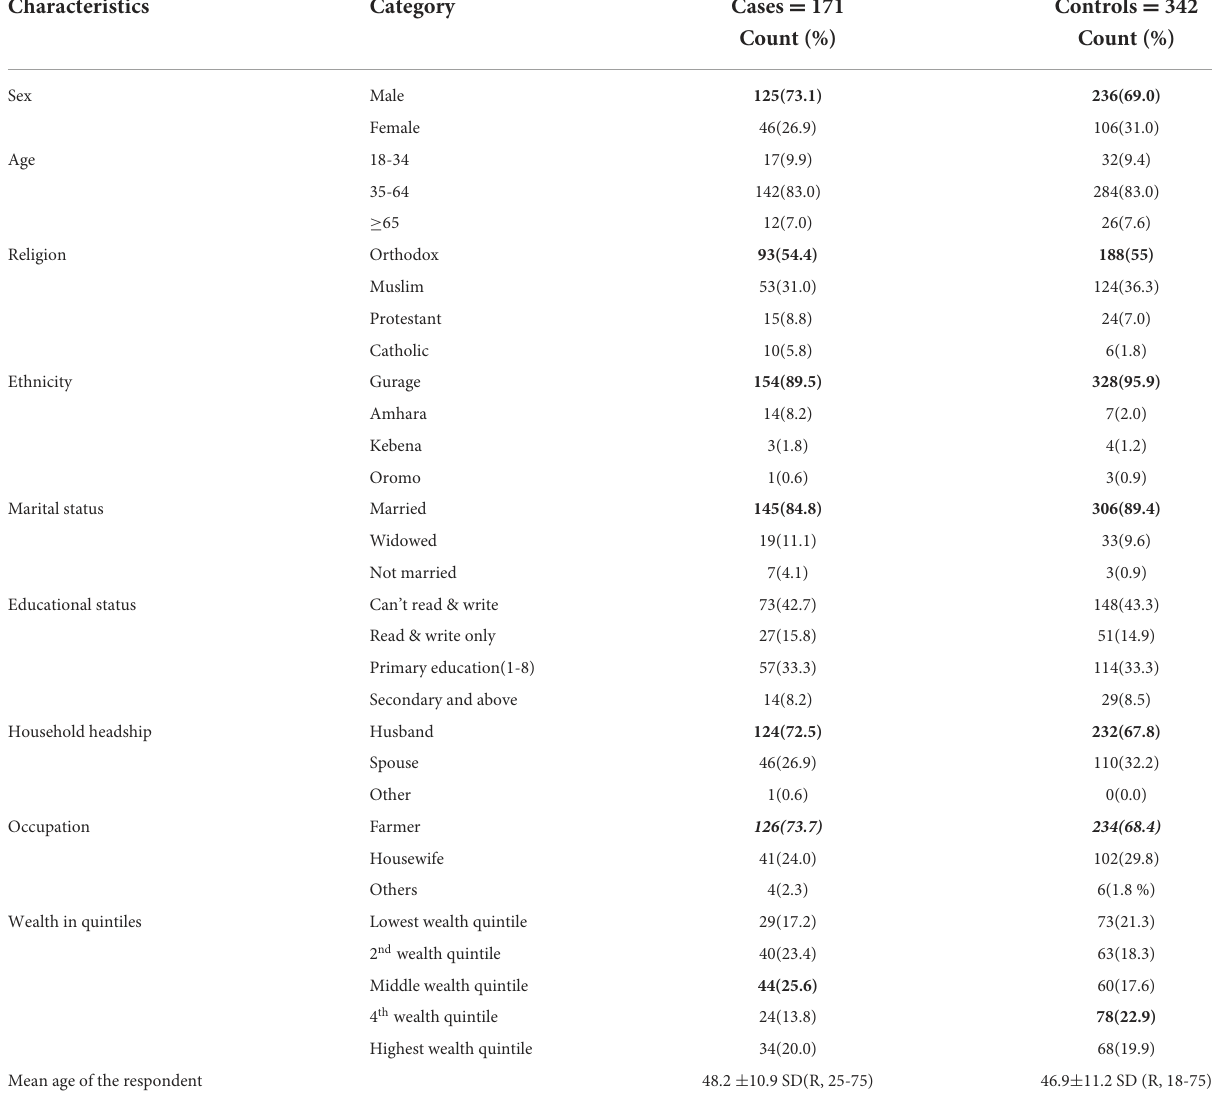
TABLE 1 Socio-demographic and economic characteristics of the cases and controls of factors influencing dropout of HH from Community-based Health Insurance membership in rural districts of the Gurage Zone, southwest Ethiopia, 2021 ( n = 513).